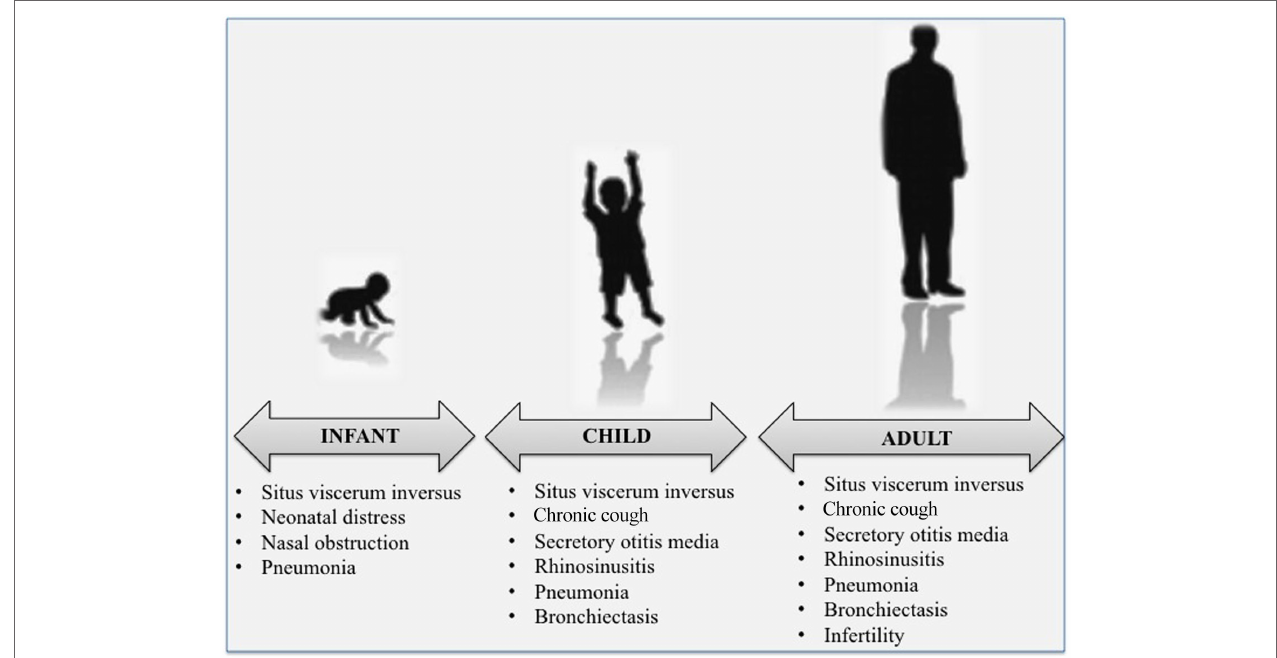
FiGURe 1 | The classical clinical phenotypes of primary ciliary dyskinesia at various